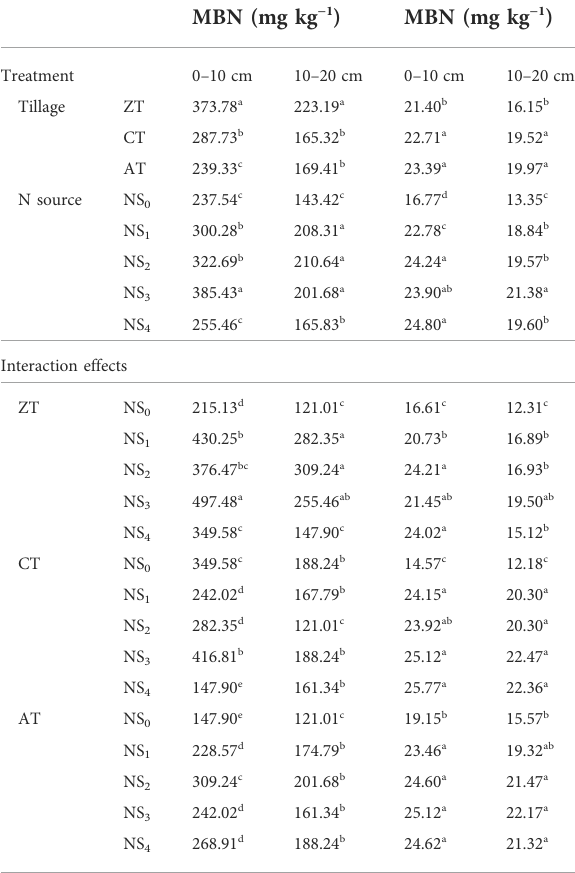
TABLE 4 Effects of tillage practices and N sources on the status of MBC (mg · kg − 1 ) and MBN (mg · kg − 1 ) in soil at the end of the